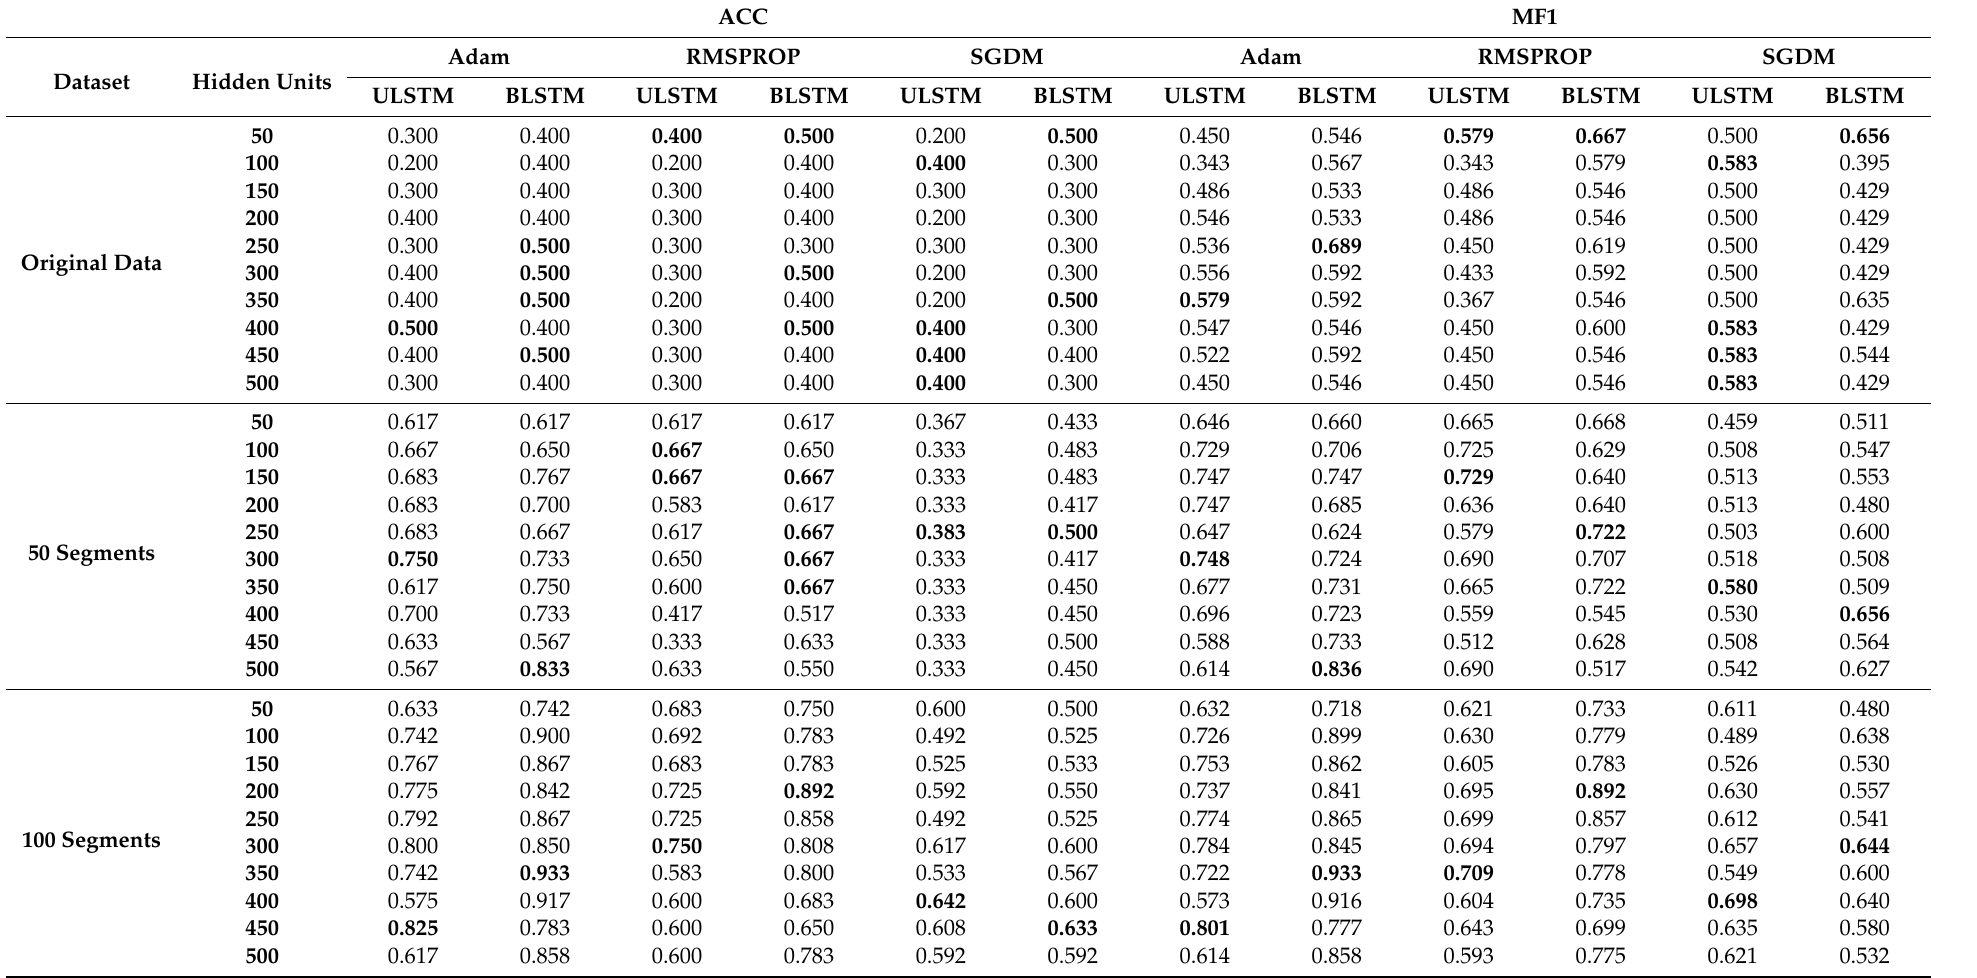
Table 12. Performance metrics of the test data from the networks trained with the 35-mer Oestrdiol dataset. ACC MF1